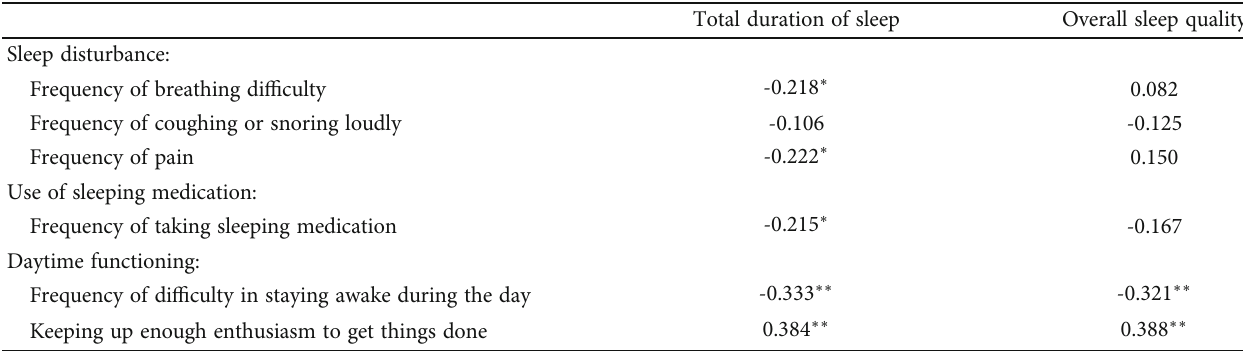
Table 5: Correlation between sleep disturbance/use of sleeping medication/daytime functioning with the total duration of sleep and the self- rated overall sleep quality.